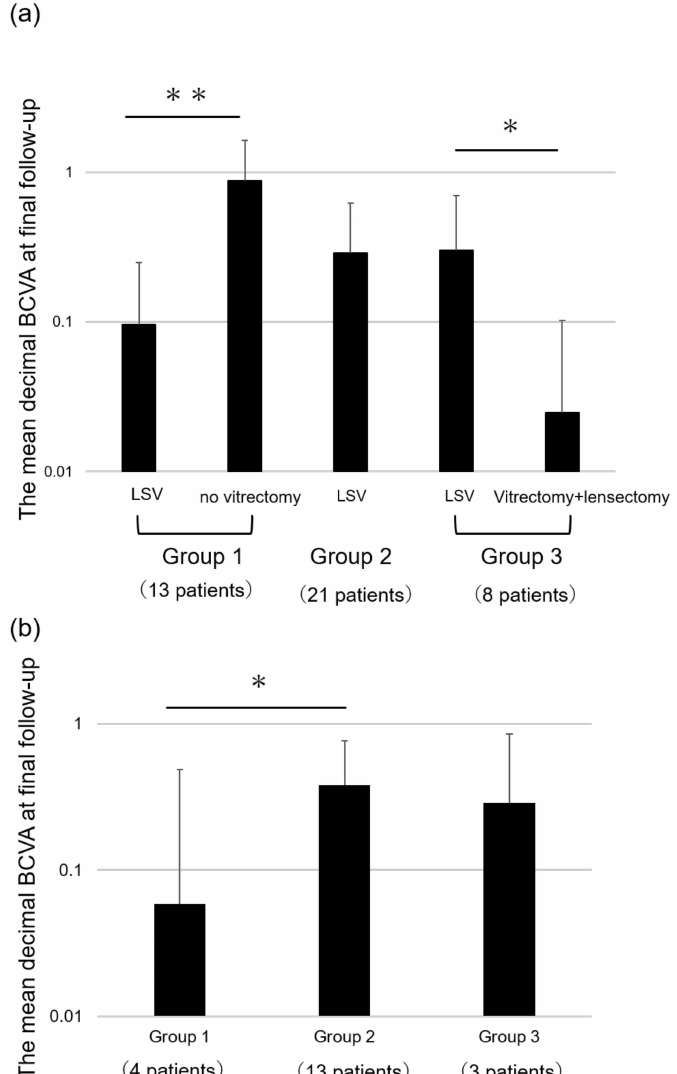
Figure 1. ( a ) Comparison between the mean decimal best-corrected visual acuity (BCVA) of eyes that underwent lens-sparing vitrectomy (LSV) and that of the fellow eyes at the final follow-up among the three groups. ( b ) Comparison of the mean BCVA of eyes that received anti-VEGF therapy before LSV at last follow-up among three groups. * p <0.05, ** p <0.001. Group 1—cases that underwent LSV but not vitrectomy in the other eye; group 2—cases that underwent LSV in both eyes; group 3—cases that underwent LSV in one eye and vitrectomy and lensectomy in the other eye. Data are presented as mean values with standard